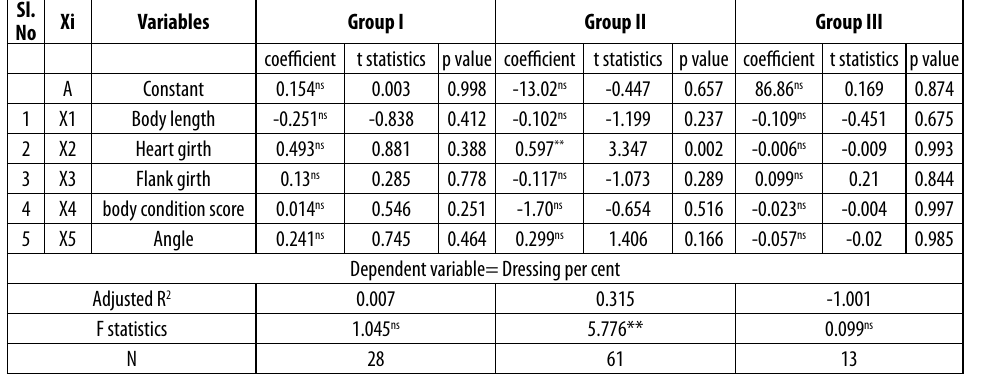
table 5. Regression analysis for developing prediction equation for dressing per cent using live animal physical body measurements in three different weight groups Sl. No